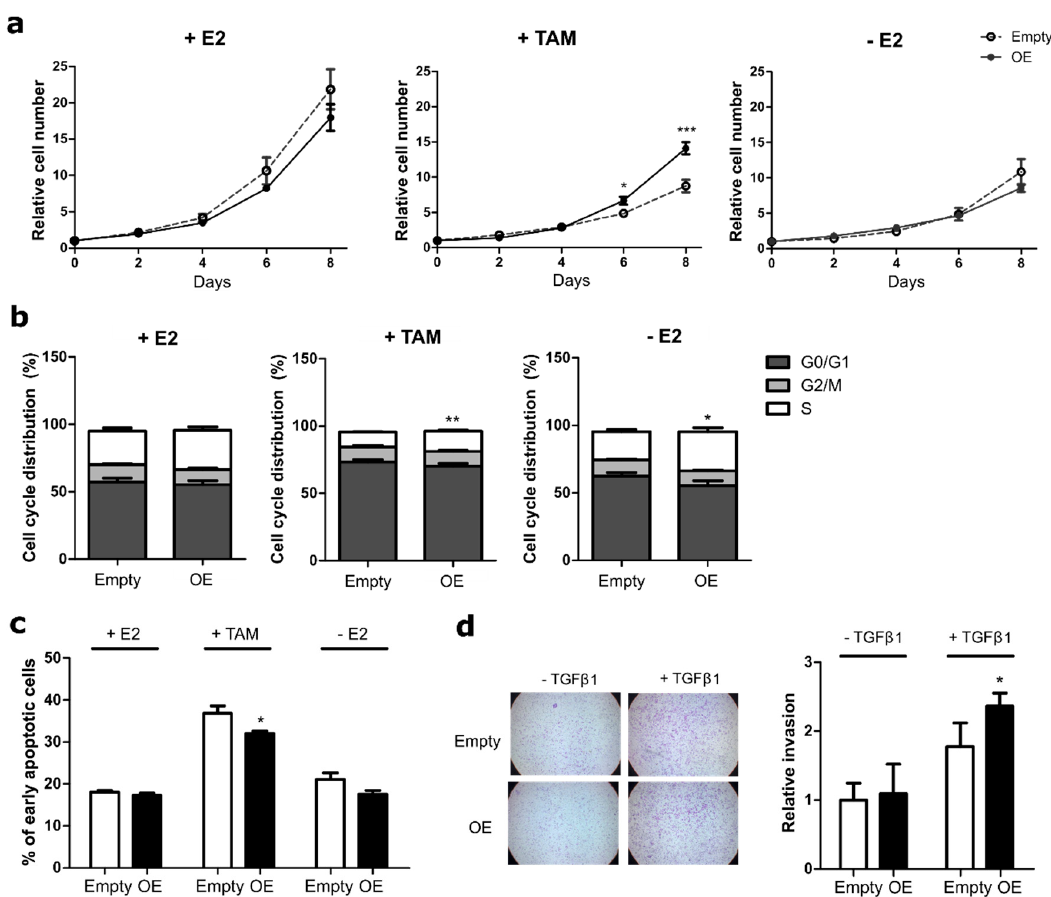
Figure 3. ATF3 overexpression reduces sensitivity to endocrine therapy in MCF7 cells. ( a ) Cell proliferation of MCF7 empty and ATF3 overexpressing (OE) cells treated for eight days with E2, TAM, or deprived from E2 and measured at indicated time points with nuclei count in fluorescent microscopy. All values are normalized to a seeding control. ( b ) Cell cycle distribution of MCF7 empty and ATF3 OE cells treated for four days with E2, TAM, or without E2. Plots represent the percentage of cells in the di ff erent cell cycle phases determined by BrdU / 7AAD staining. Statistics performed on the S phases (white bars) ( c ) Measurement of apoptosis rate in MCF7 empty and ATF3 OE cells treated for four days with E2, TAM and without E2. Plots represent the percentage of early apoptotic cells determined by Annexin V / PI staining. ( d ) Representative microscopy images of transwell invasion assay through Matrigel and relative quantification of the number of invading cells. Values are expressed as relative to the unstimulated WT control. Data are represented as mean ± SEM, n = 3. *** p -value < 0.001, ** p -value < 0.01, * p -value < 0.05.